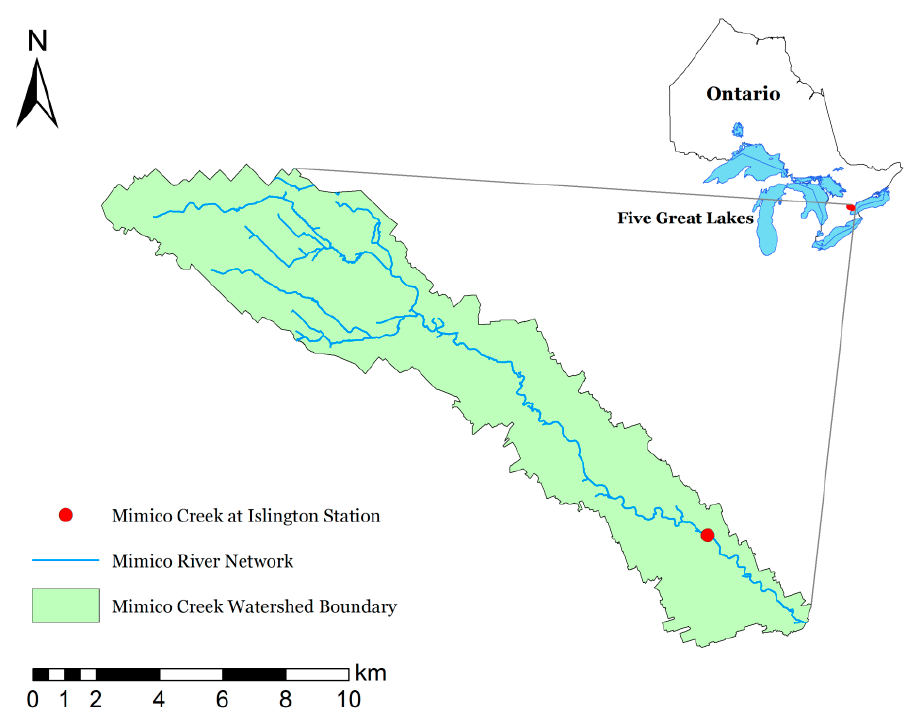
Figure 1. Mimico Creek watershed and location of the streamflow station (Mimico Creek at Islington) on the map of Ontario.